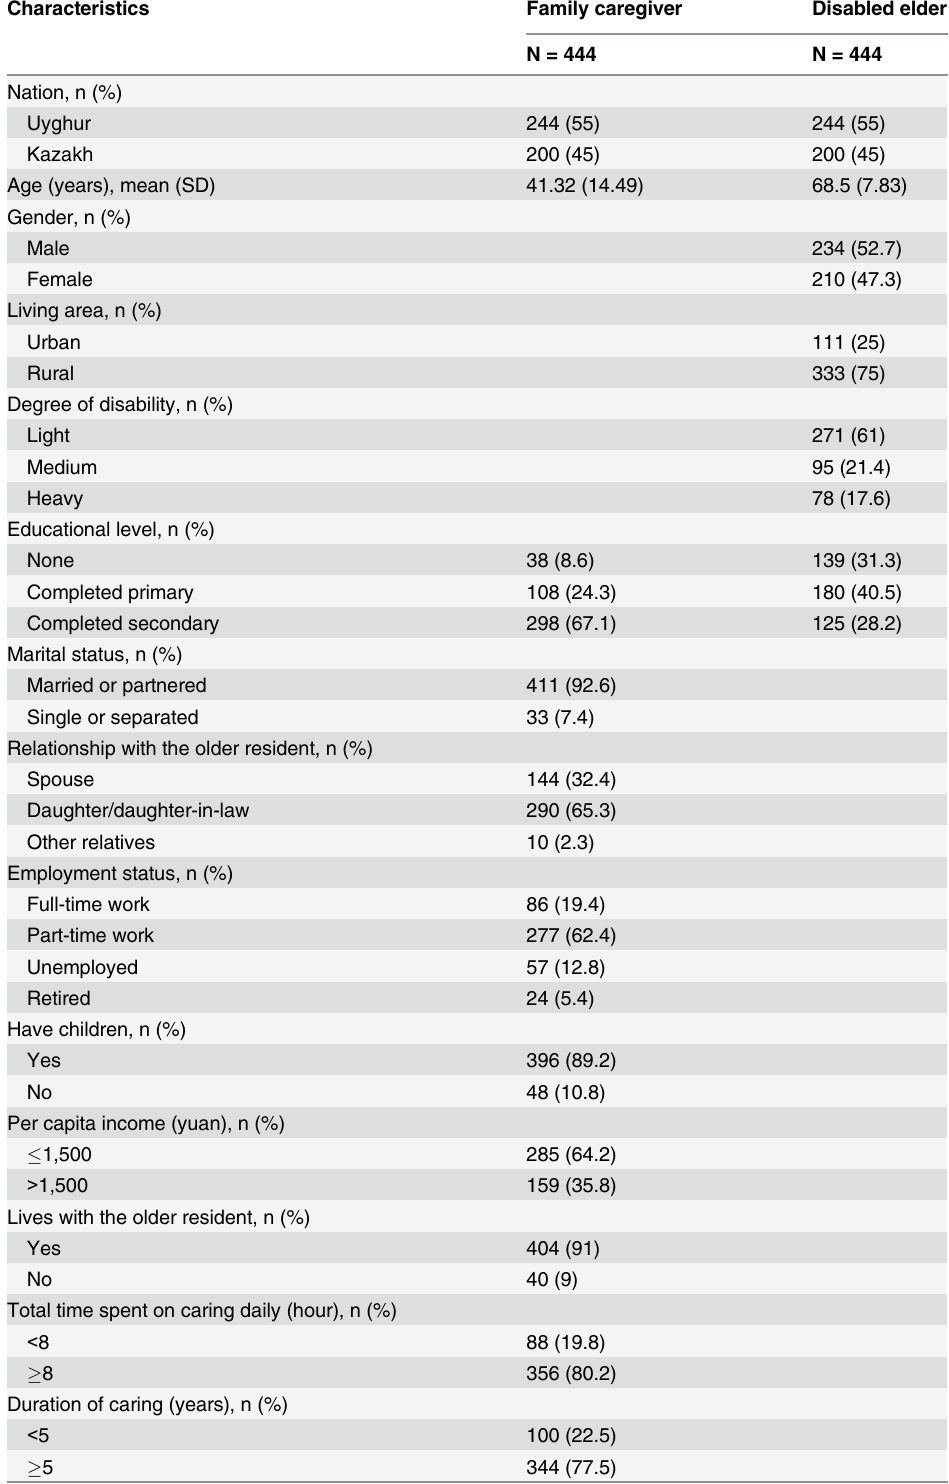
Table 1. Demographic characteristics of informal caregivers and disabled elders. Characteristics Family